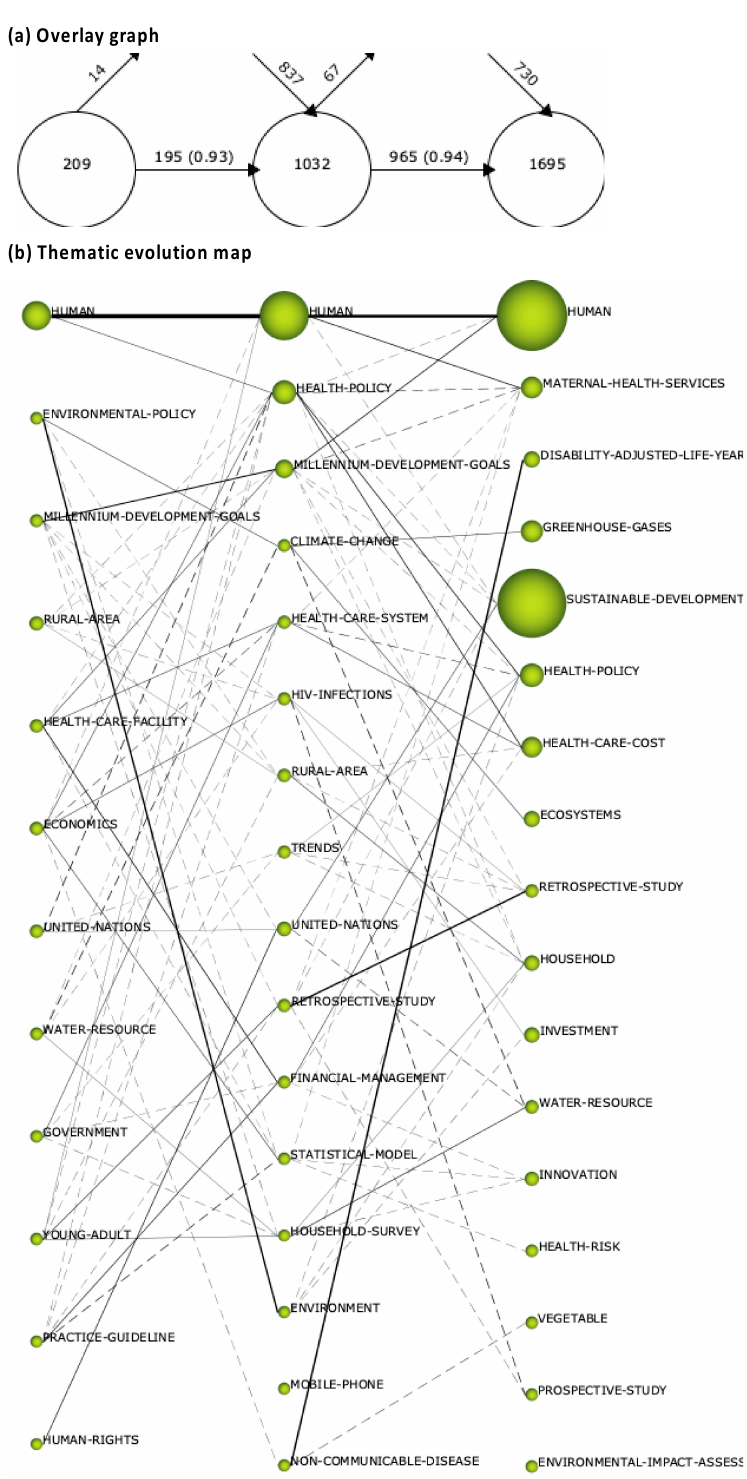
Figure 7. ( a ) Overlay graph and ( b ) thematic evolution map.